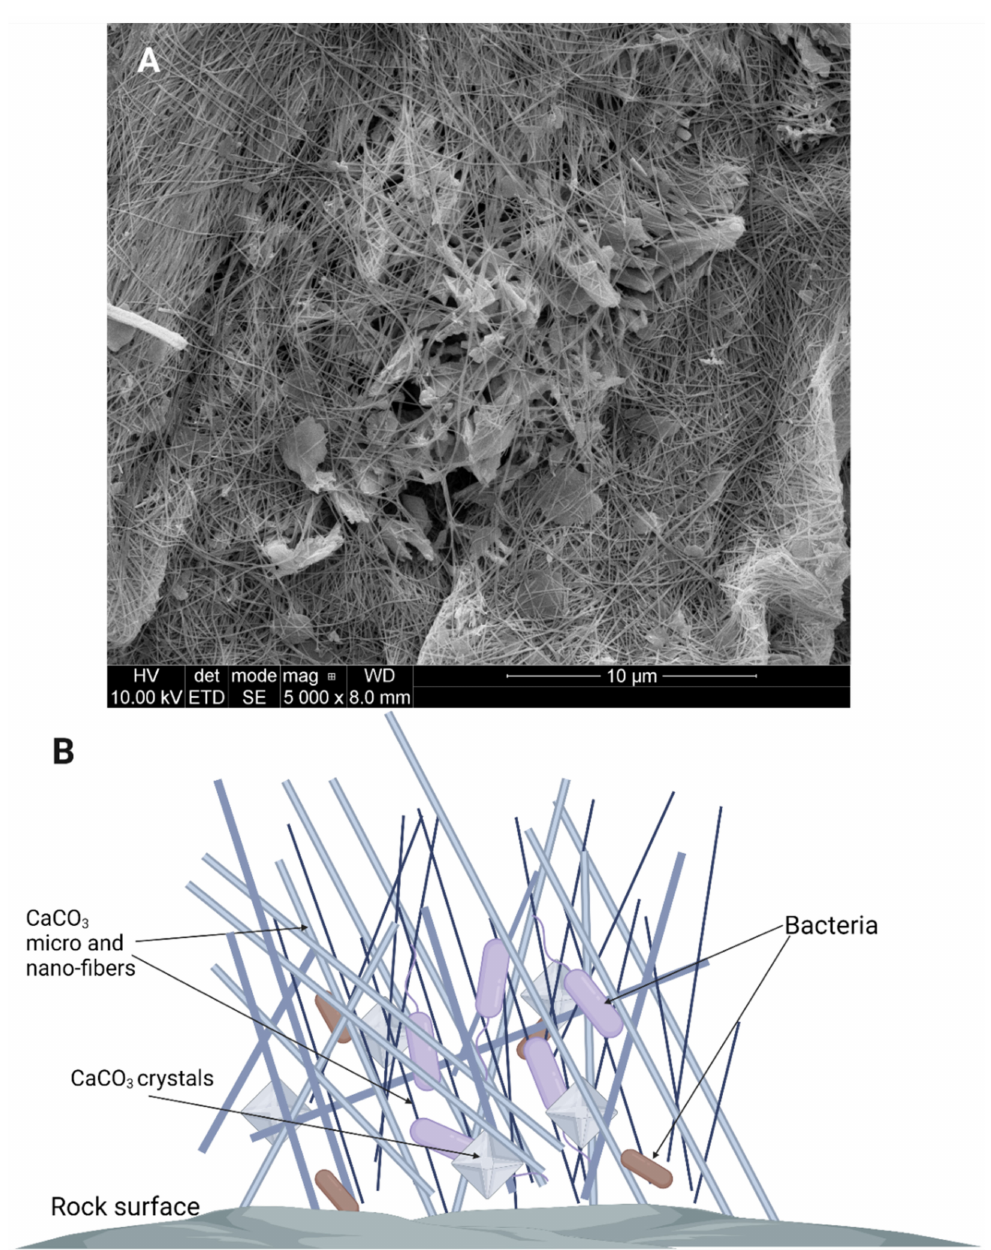
Figure 5. Moonmilk composition shown as images from SEM (( A ) Source: Piotr Golec) and on a schematic ( B ). The SEM image was obtained from a moonmilk sample from Szczelina Chochołowska, Tatra Mountains, Poland, with the use of FEI Quanta 250 FEG Scanning Electron Microscope. The sample was obtained and prepared by Daria Lubomska. Created with BioRender.com (accessed on 4 January